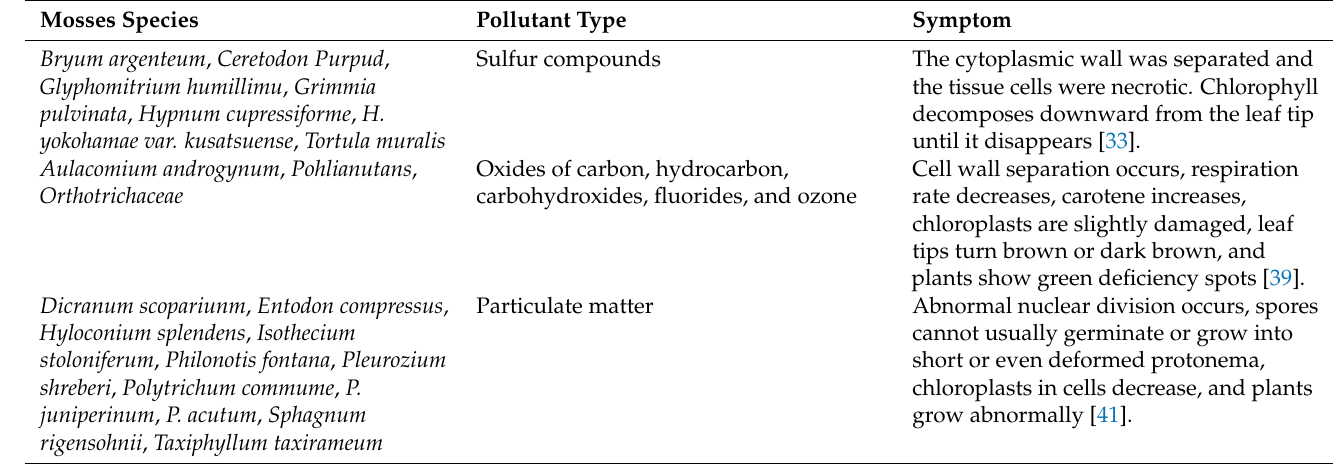
Table 2. Performance of different mosses in atmospheric pollutants'